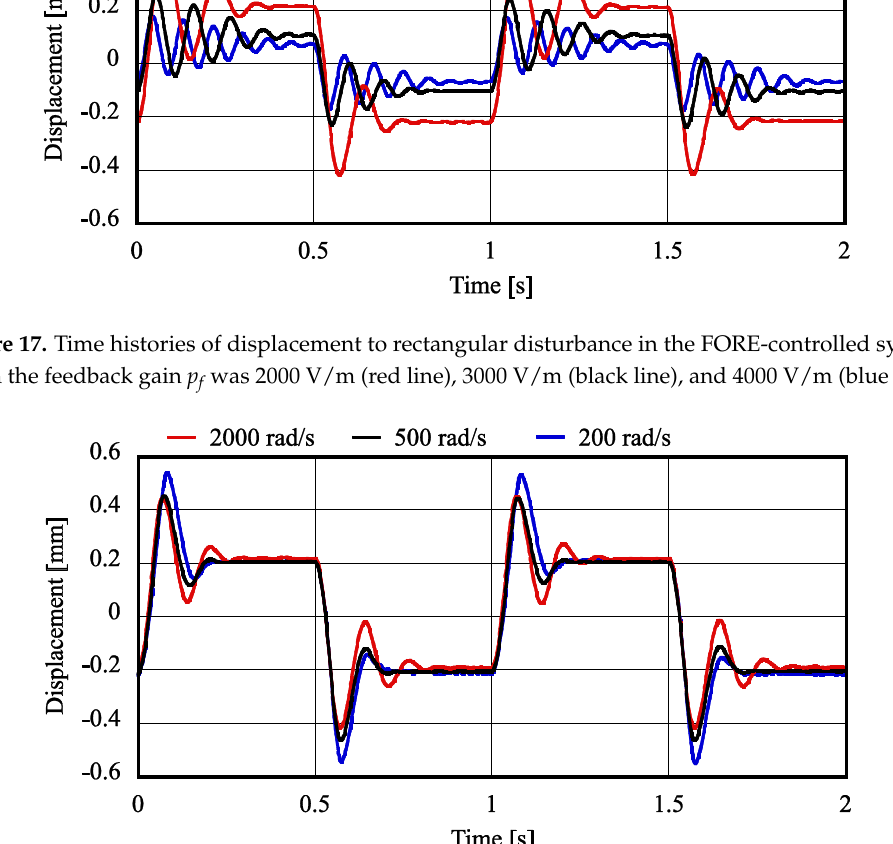
Figure 18. Time histories of displacement to rectangular disturbance in the FORE-controlled system when the cutoff angular frequency α was 2000 rad/s (red line), the same as the response in Figure 17, 500 rad/s (black line), and 200 rad/s (blue line).